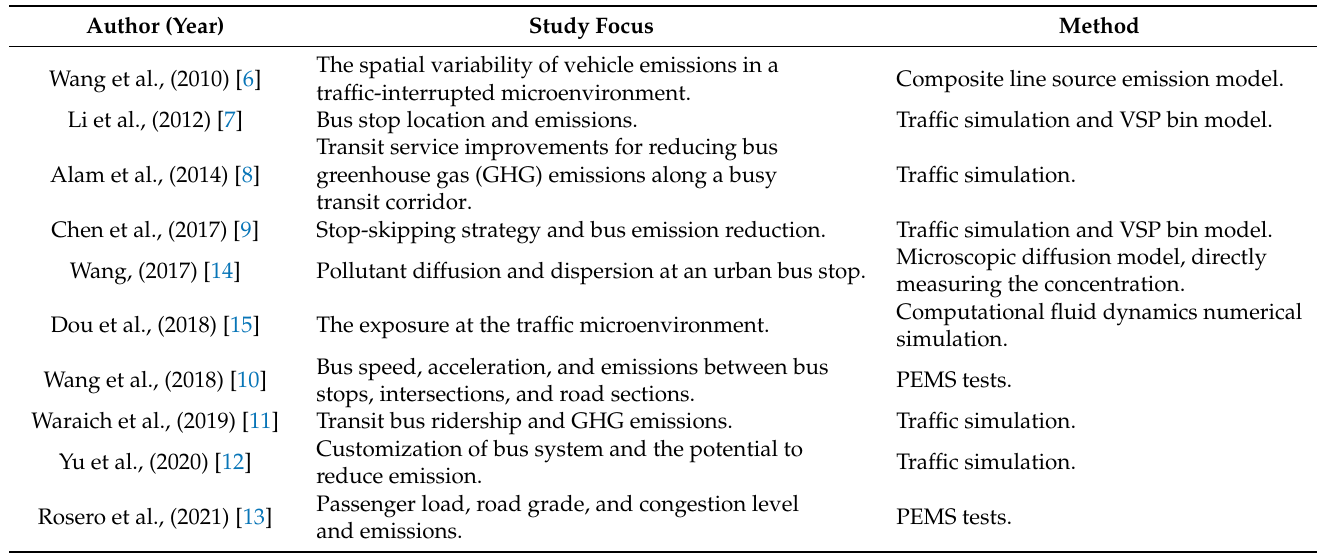
Table 1. Summary of previous studies on bus